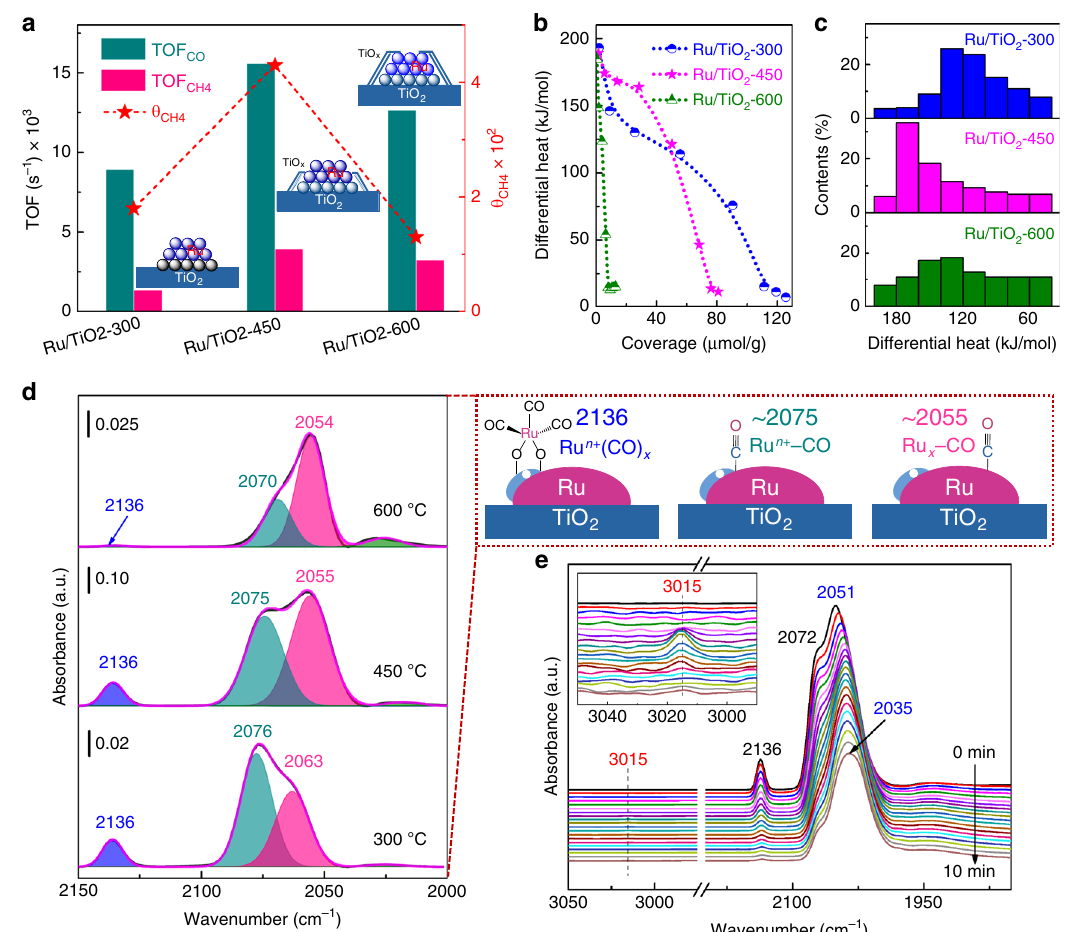
Fig. 4 The participation of the TiO x overlayer in the C – O bond dissociation. a The correlation between the intrinsic activity (TOF CO and TOF CH4 ) and the coverage of active surface CH x intermediates (represented by θ CH4 ) as obtained by SSITKA experiments. Performing condition: 200 °C, 0.185 MPa, H 2 /CO = 10. b , c Microcalorimetric measures of CO chemisorption and the distribution of differential heat on the Ru/TiO 2 - x samples. d In situ DRIFT spectra obtained after CO adsorption and evacuation with helium at 160 °C, over the Ru/TiO 2 - x catalysts. e Evolution of the CO ad species during H 2 fl ow at 160 °C as determined using in situ DRIFT spectra, over the Ru/TiO 2 -450 differential heat of 120 – 150 kJ mol − 1 for CO chemisorption on the Ru sites. In contrast, the over-coverage of TiO x on Ru NPs causes a shortage of both the Ru sites and the interfaces for CO chemisorption/dissociation on Ru/TiO 2 -600.